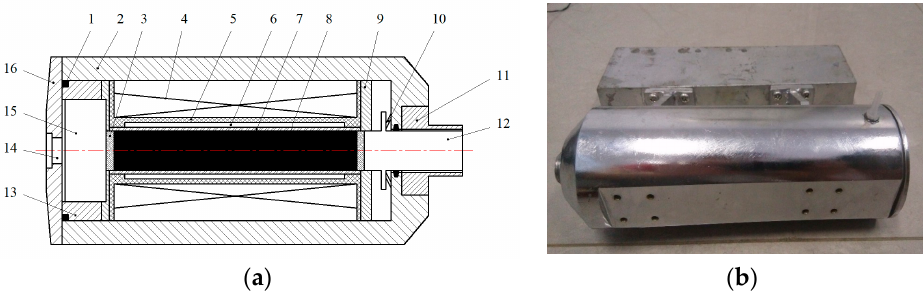
Figure 1. The structure diagram of the transducer. ( a ) Structure diagram. 1-Sealing ring; 2-Case; 3-Permanent magnet; 4-Coil; 5-Bobbin; 6-Cooling water; 7-Sleeve; 8-Terfenol-D rod; 9-Magnetic sheets; 10-Disc spring; 11-Connectors; 12-Output rod; 13-Adjustment ring; 14-Inout port; 15-Balance weight; 16-Back cover; ( b ) The assembled transducer.